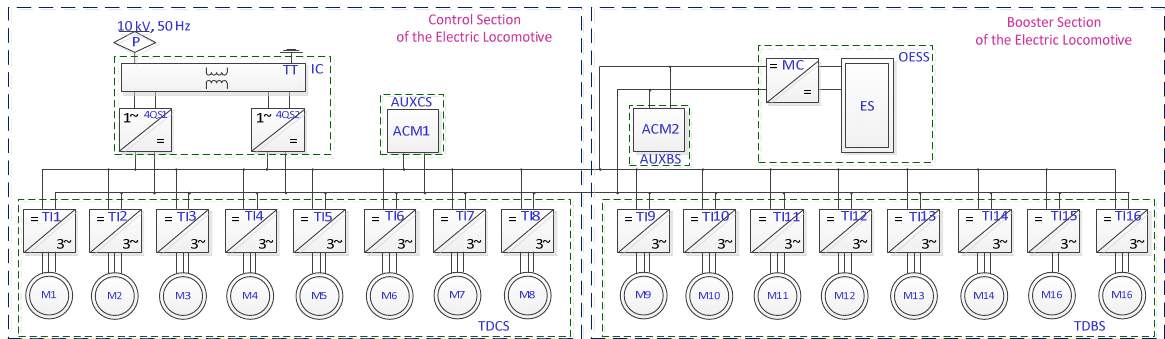
Figure 2. Structural diagram of the traction system for the electric locomotive (P—pantograph, IC—